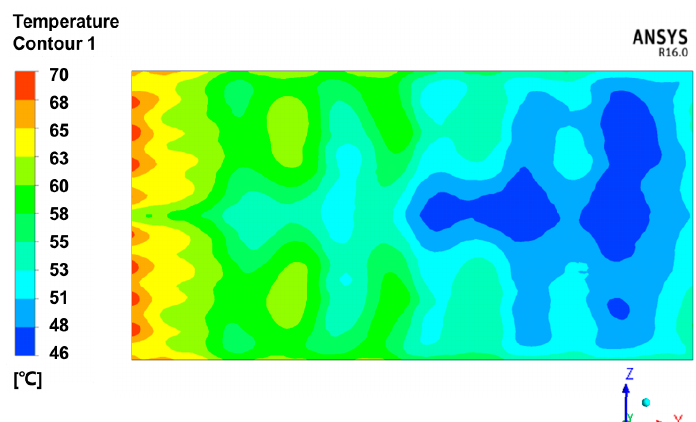
Figure 10. The temperature contour plot of the mold panel surface at 30 min.